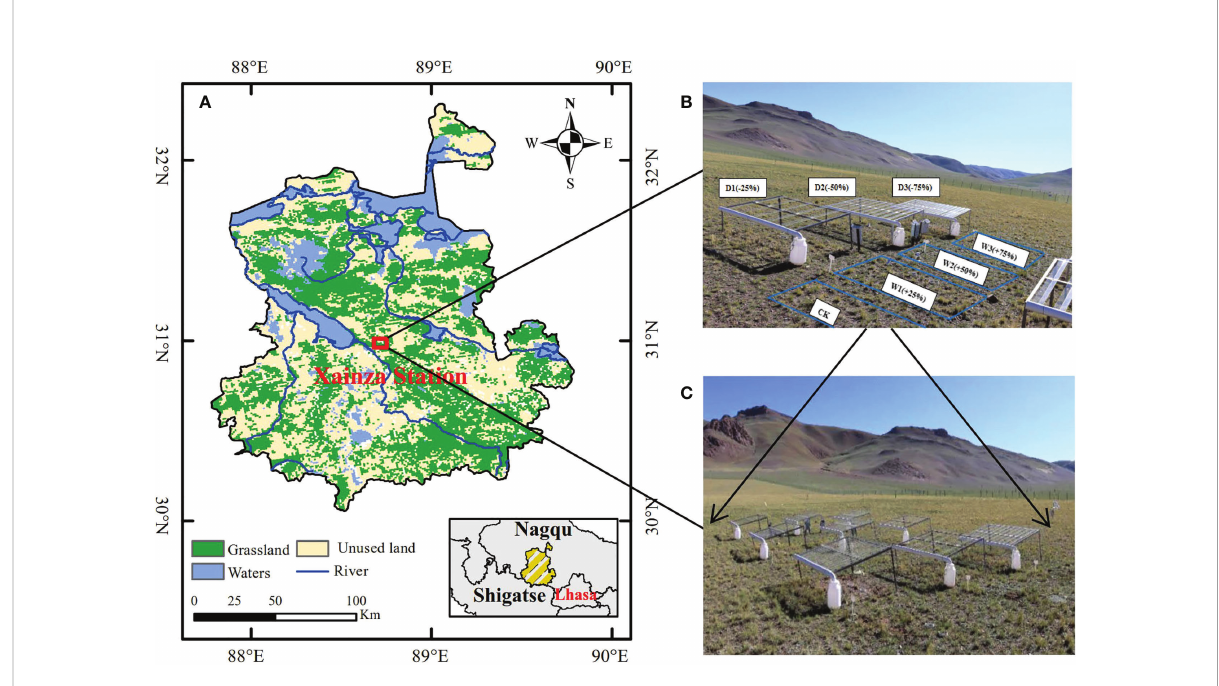
FIGURE 1 Location of the study area and design of the experiment. (A) Location of Xainza Station; (B) Diagram of the seven precipitation treatments; (C) Complete experimental site with three blocks and 21